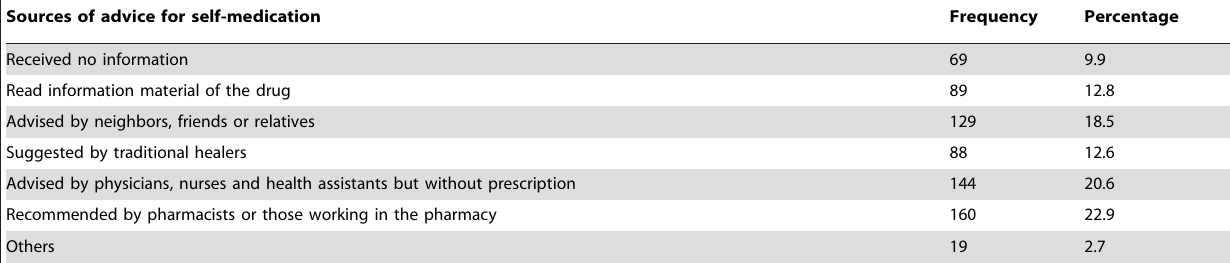
Table 4. Sources of advice for self-medication